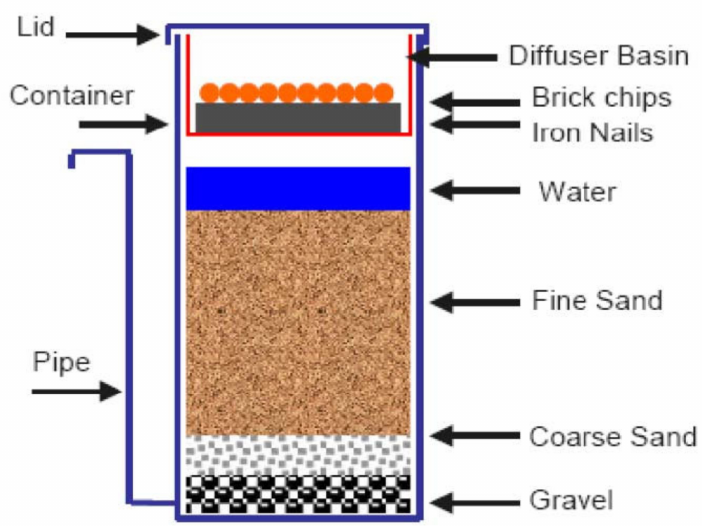
Figure 6. Components of a Kanchan Arsenic Filter [160]. Reproduced with permission from Taylor &